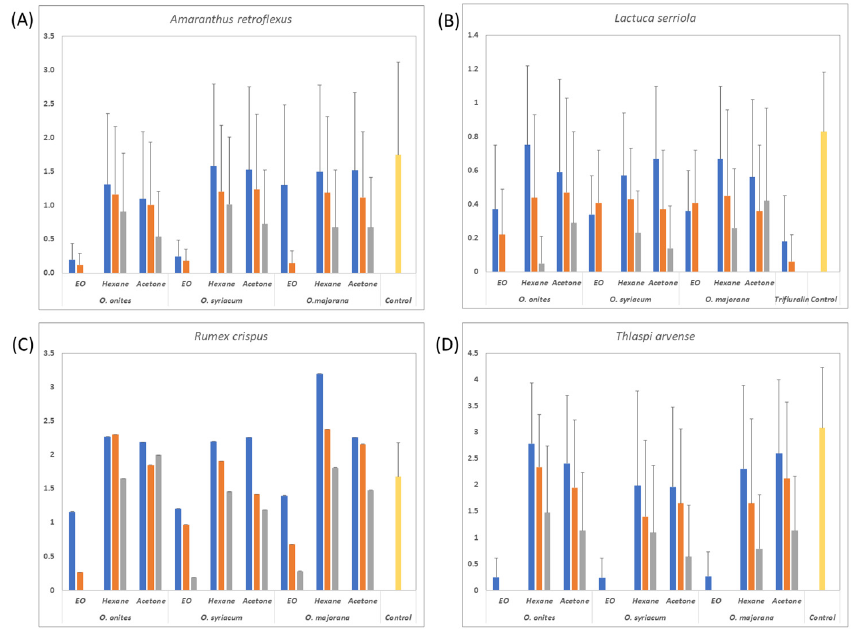
Figure 3. The shoot development of the weeds (cm). ( A ) Amaranthus retroflexus , ( B ) Lactuca serriola , ( C ) Rumex crispus , ( D ) Thlaspi arvense . Blue bars indicate 5 µL dose application while red bars 10 µL, grey bars 20 µL. The yellow bars indicate control application.